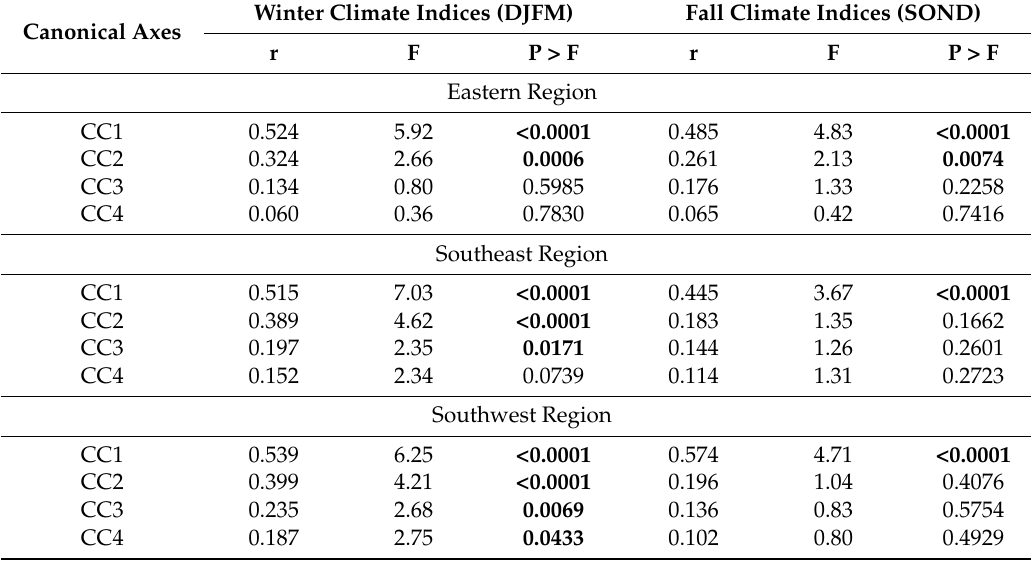
Table 2. Comparison of canonical correlation coefficients (r) as a function of seasonal climate indices.